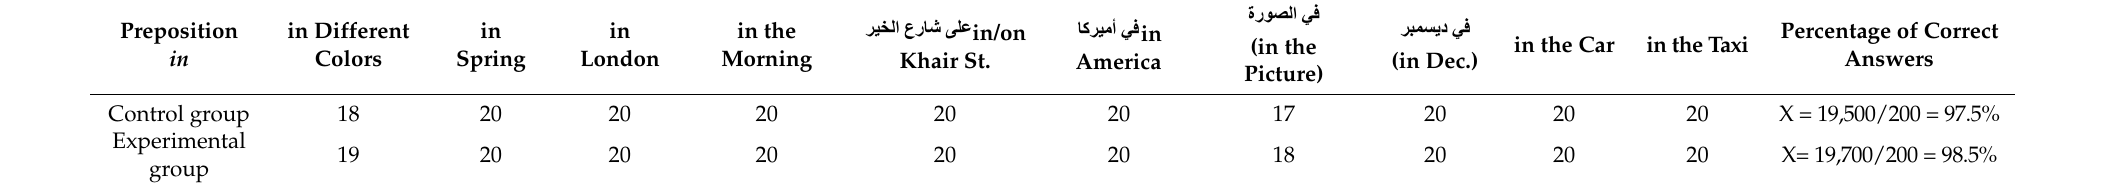
Table 3. Pretest pf the preposition in .